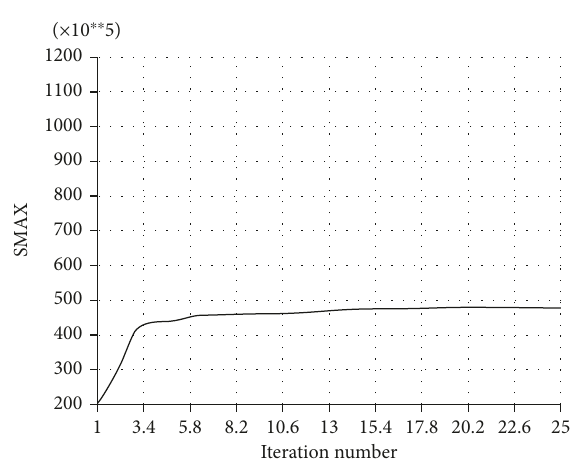
Figure 22: The state variable curve.